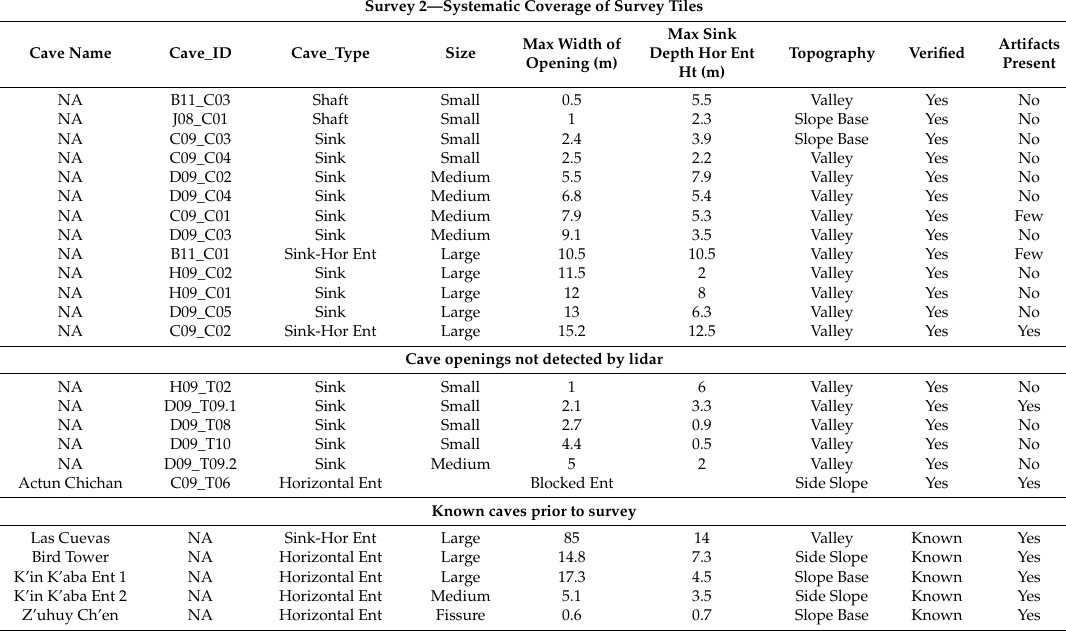
Survey 2—Systematic Coverage of Survey